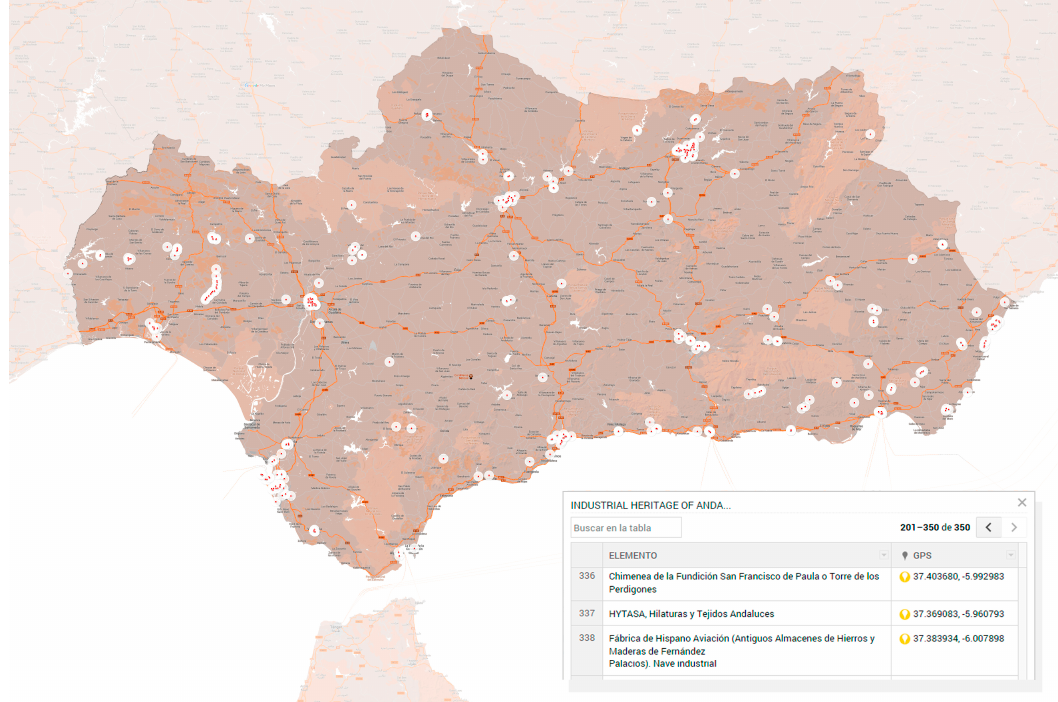
Figure 1. Visualization of the assets identified in Andalusia within a map created using Google My Maps and thanks to the geolocation information included for each asset in the catalogue.